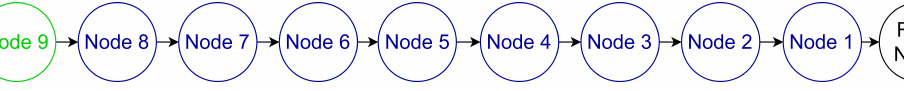
Figure 15. Linear